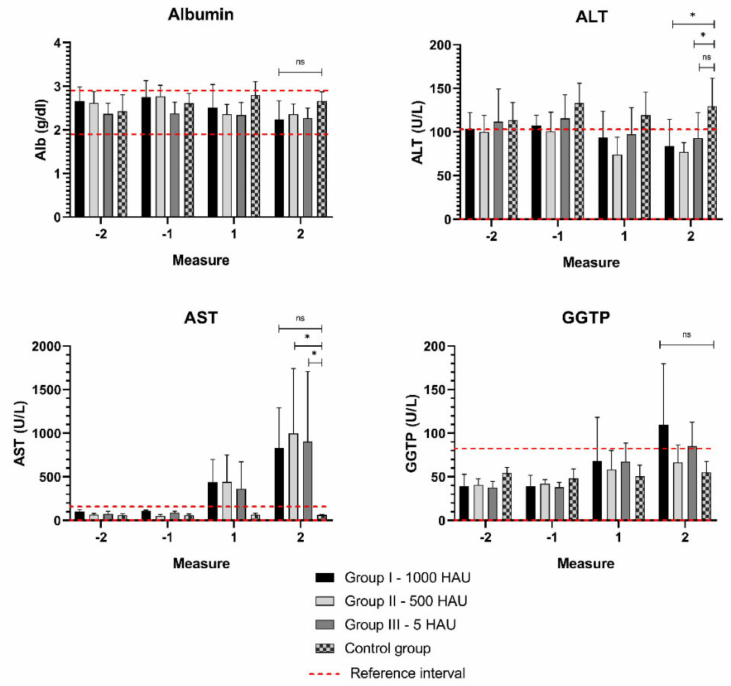
Figure 3. Mean parameters of the hepatic profile. Measurement − 1, − 2 - two measurements before viremia, measurement 1,2 - the last two days of life with viremia. ALT - alanine aminotransferase; AST - aspartate aminotransferase; GGTP - γ -glutamyltranspeptidase; ns - statistically insignificant; * - statistically significant ( p = 0.01–0.05). Error bars indicate standard